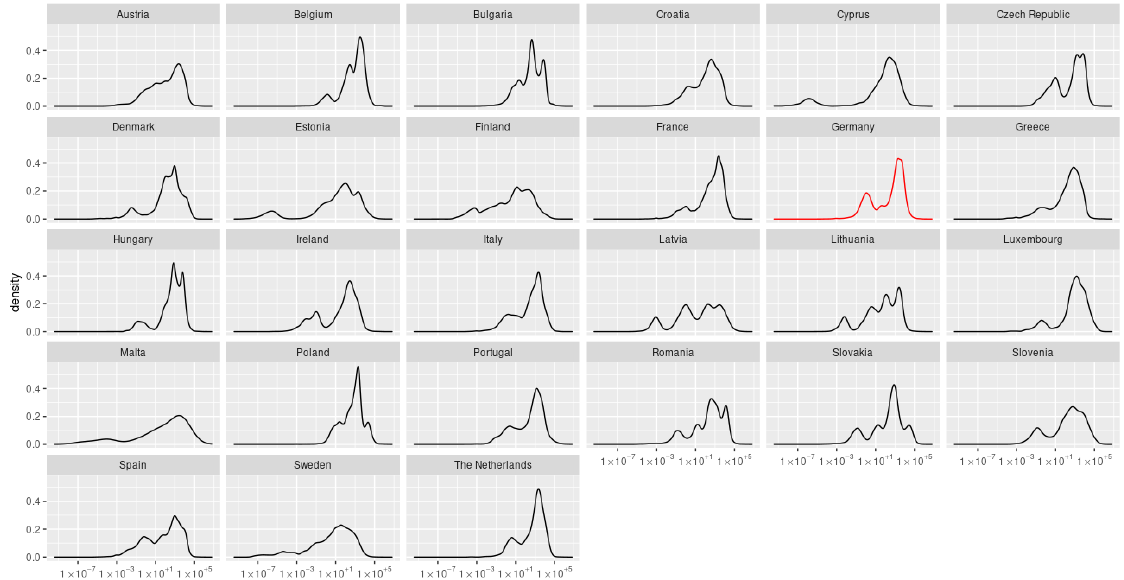
Figure 8. Density functions of the spatially distributed emissions 2010 from the MACC-III (Monitoring Atmospheric Composition and Climate) project by the European Union in kilotons per 7 × 7km 2 ( log 10 -scaled abscissa) in the EU-27 member states based on data from the Netherlands Organisation for Applied Scientific Research (TNO). Germany is highlighted with a red density